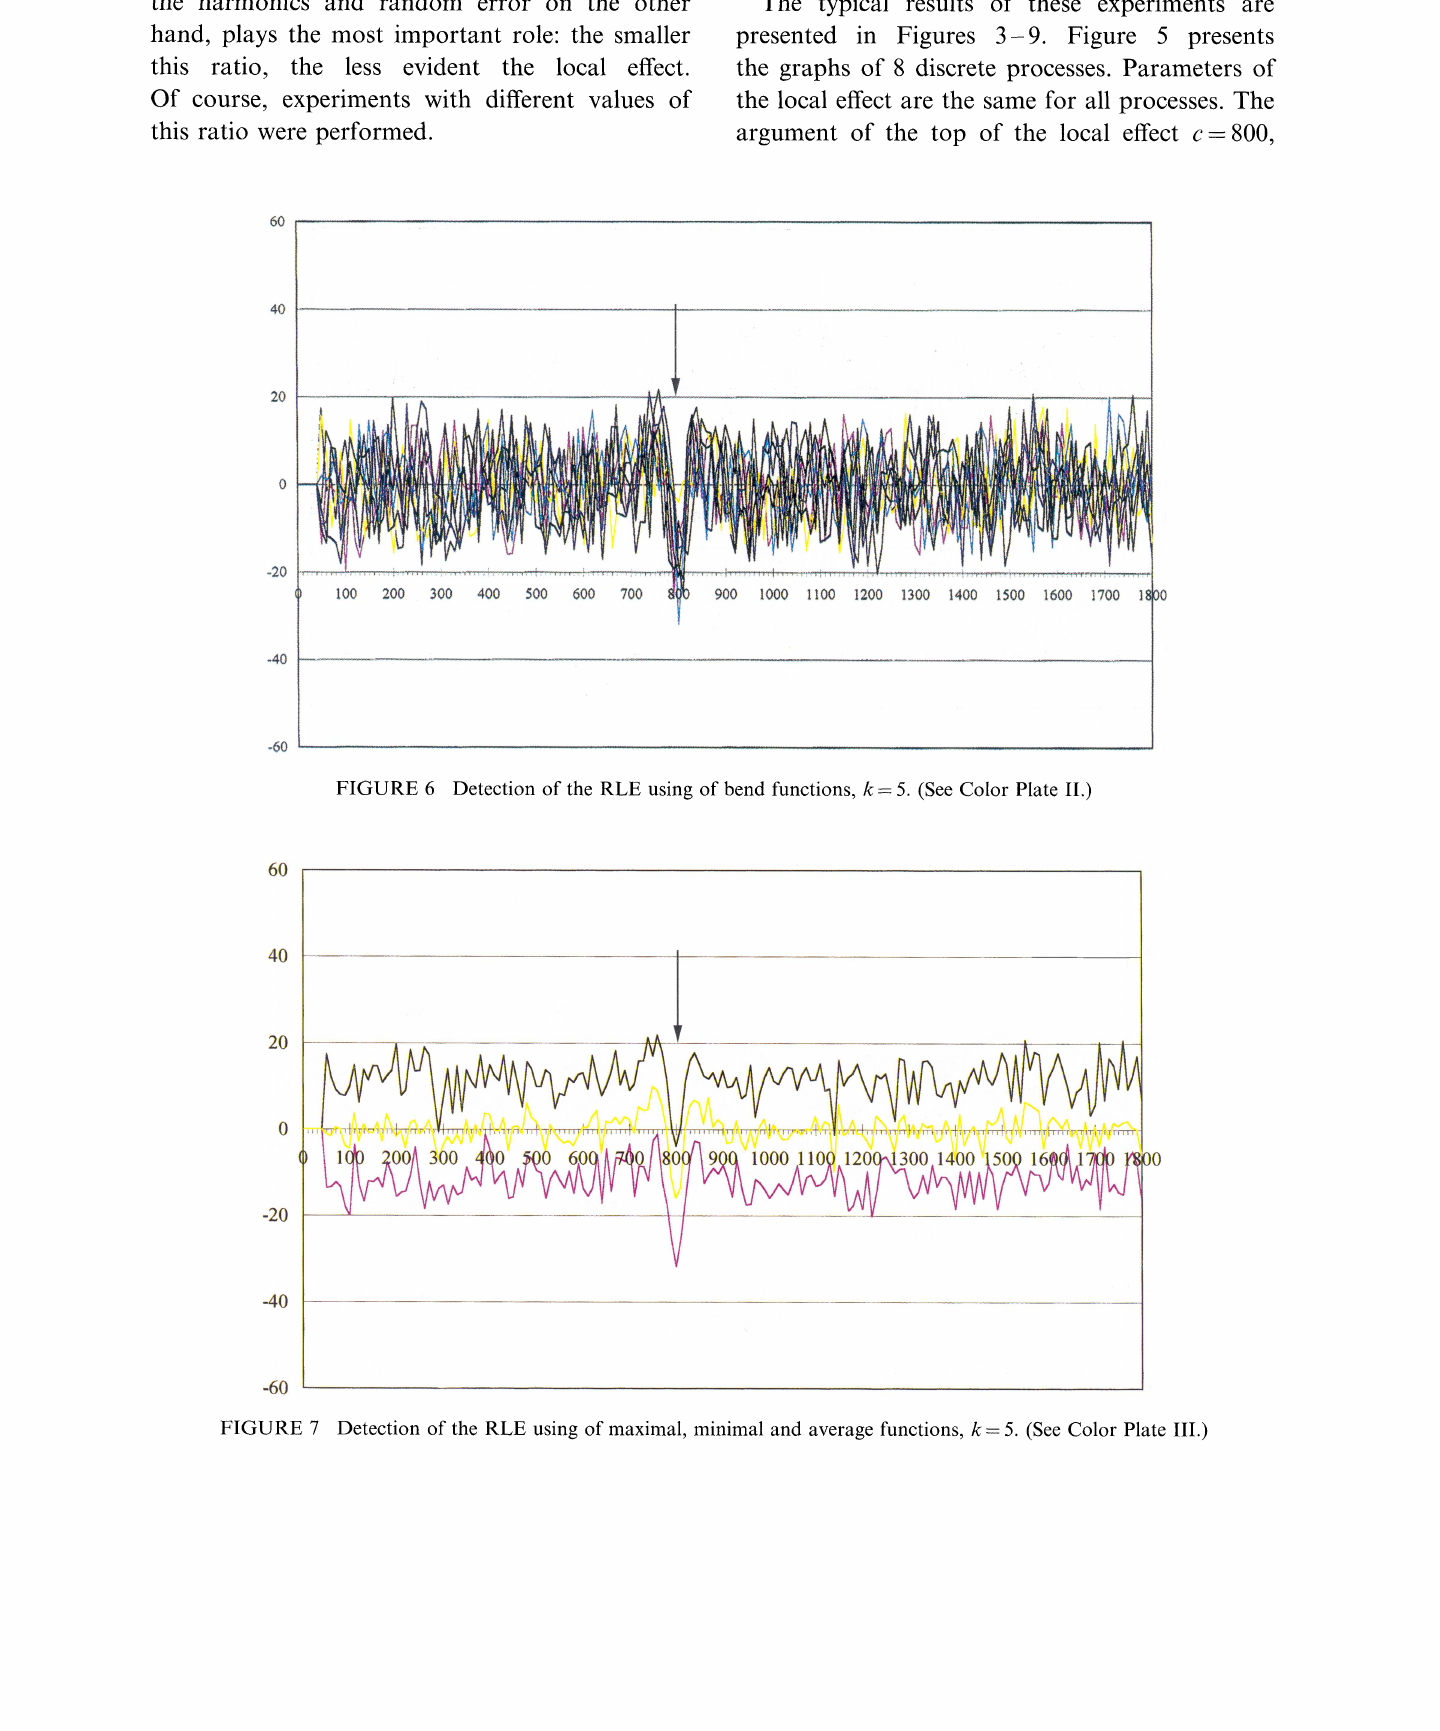
FIGURE 7 Detection of the RLE using of maximal, minimal and average functions, k 5. (See Color Plate